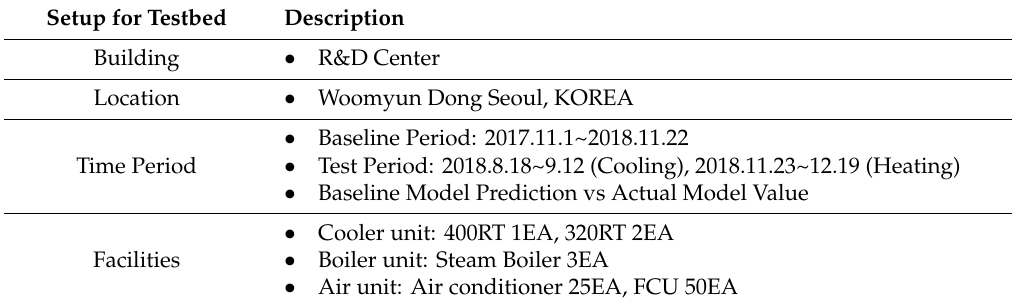
Table 1. Setup of field test for energy e ffi ciency.